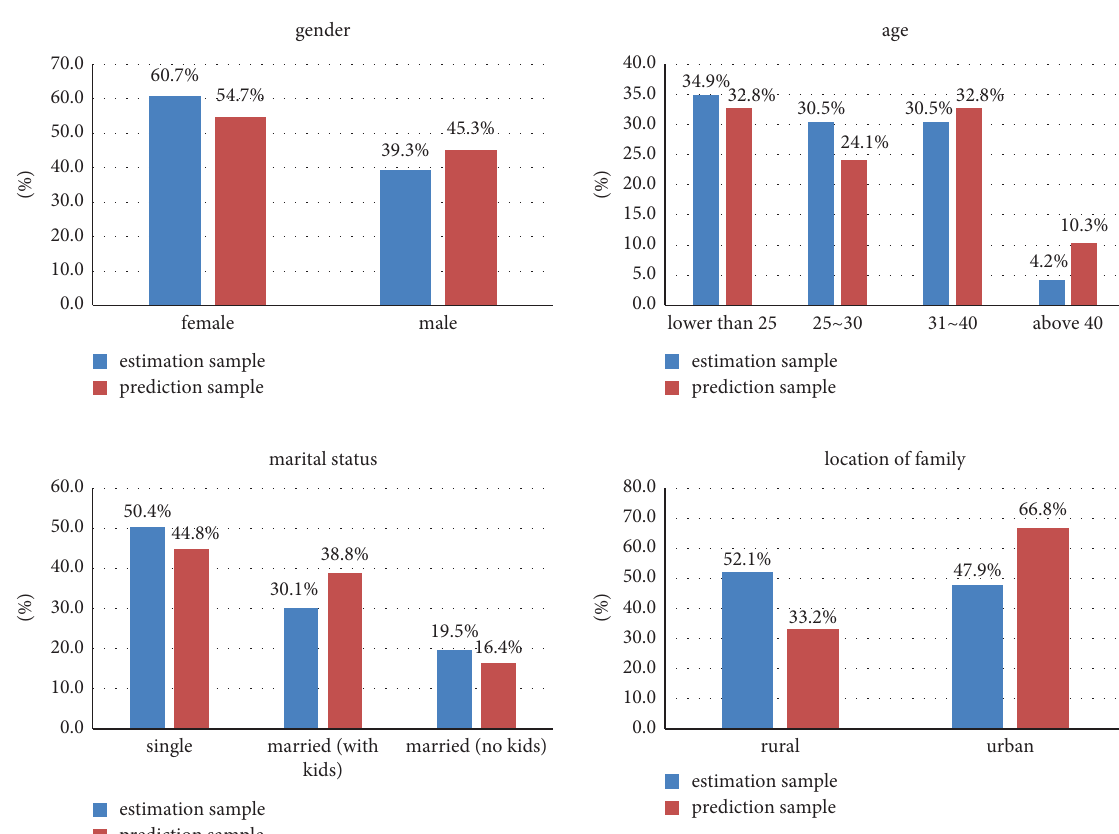
Figure 3: Descriptive statistics of respondents’ sociodemographic